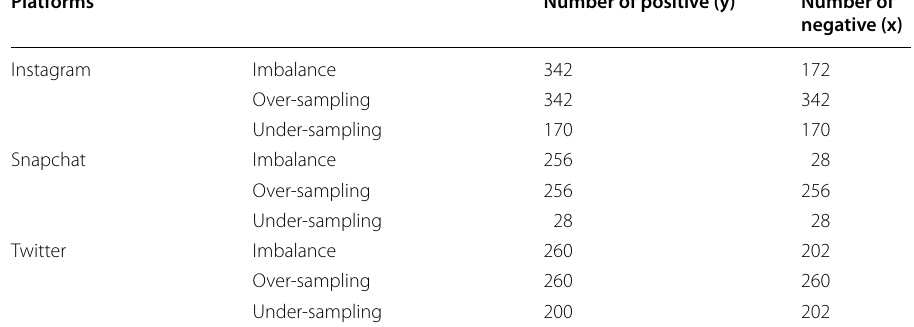
Table 4 Number of positive and negative sentiment when data re-sampling Platforms